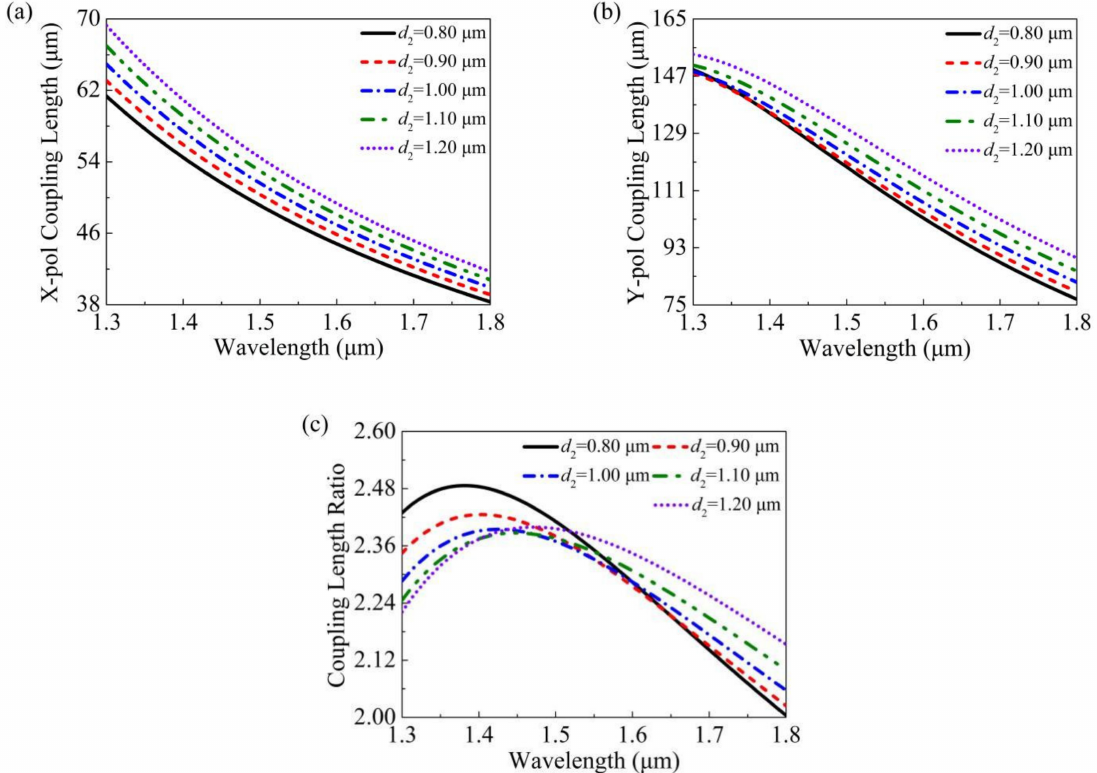
Figure 7. The change rules of the ( a ) CL X , ( b ) CL Y , and ( c ) CLR of the LC-DC-PCF with wavelengths Figure